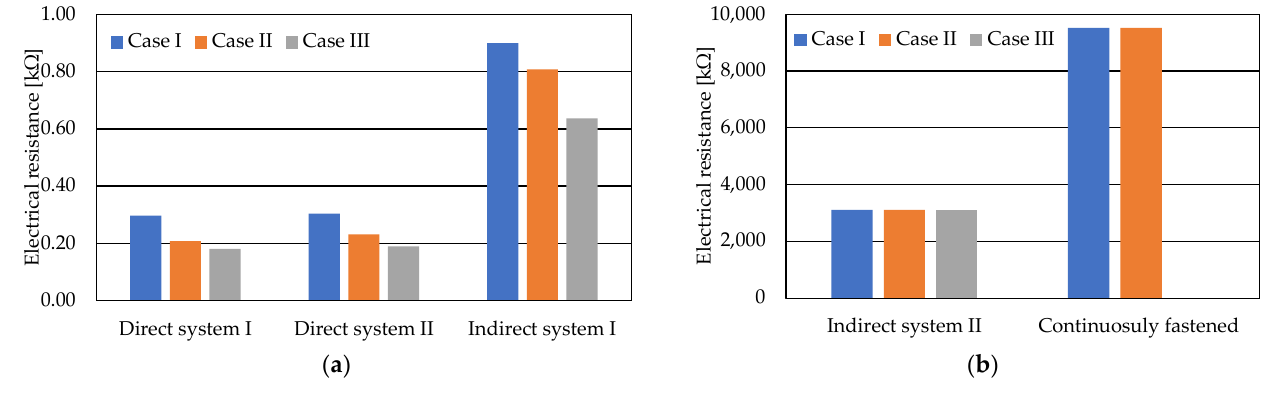
Figure 14. Measured electrical resistance values in different cases for: ( a ) two different direct fas- tening systems and an indirect fastening system where anchor bolts are not insulated, ( b ) an indi- rect fastening system with insulated anchor bolts and a continuously fastened rail sample.